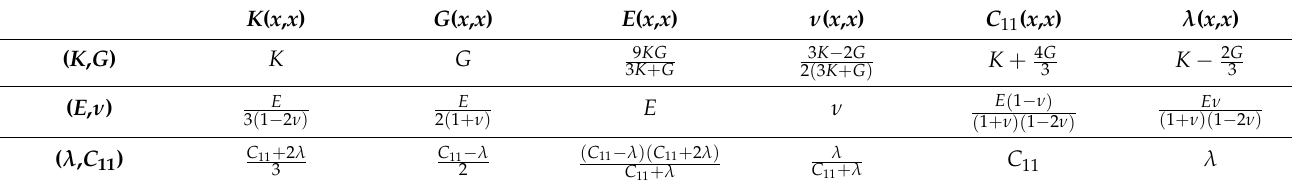
Table 1. Relations between different elastic moduli for homogeneous and isotropic materials. E is the Young modulus, ν is the Poisson’s ratio, C 11 is the first matrix element of the stiffness tensor, and λ is the first Lam é parameter. The parentheses indicate that the quantity is a function of two